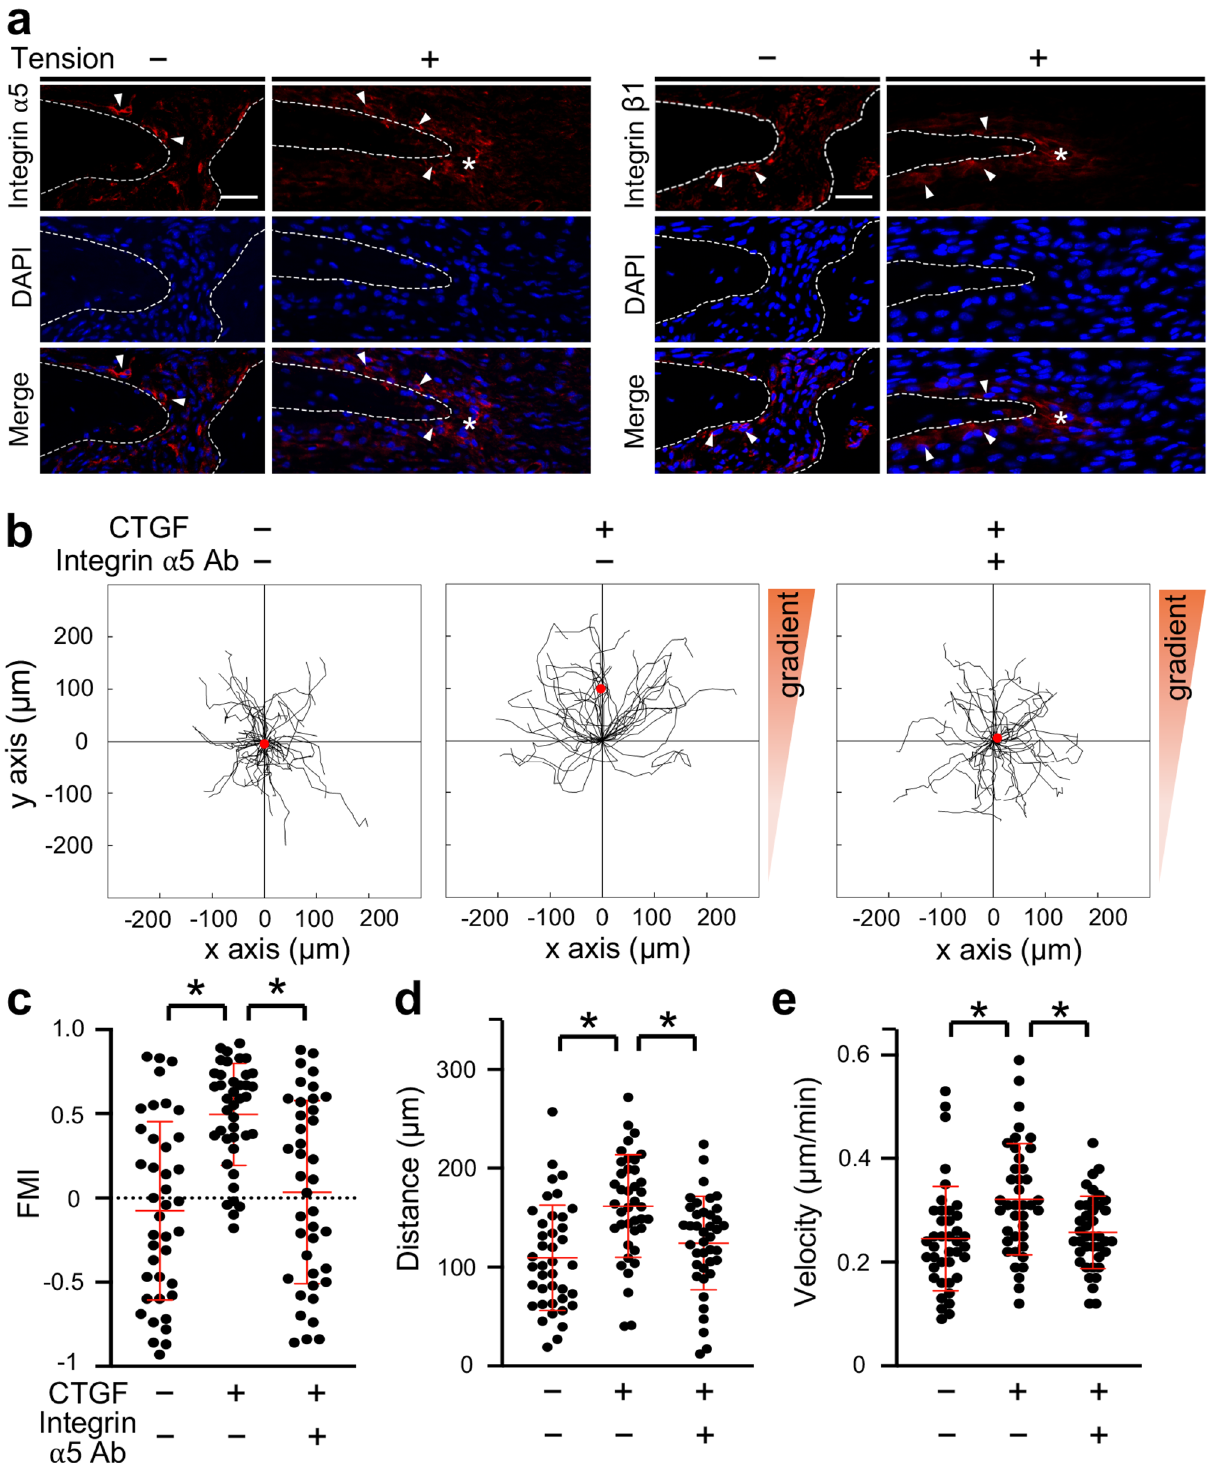
Figure 5. Neutralizing integrin α5 antibody suppressed the CTGF-induced chemotaxis of MC3T3-E1 cells. ( a ) The expression of integrin α5 and integrin β1 at the osteogenic front at 7 days after application of tensile force was analyzed by immunohistochemistry. Arrowheads indicate integrin α5- or integrin β1-positive osteoblasts. Asterisks indicate expression of integrin α5 or integrin β1 at the osteogenic front. The dotted line in the image of immunohistochemistry indicates the border of mineralized bone. Scale bar = 30 μm. ( b ) MC3T3-E1 cells were seeded onto an observation area between two reservoirs in a μ-slide chemotaxis chamber and cultured overnight. The cells in the observation area were pretreated with 5 μg/ml neutralizing integrin α5 antibody for 1 h. Then 150 ng/ml CTGF with or without 15 μg/ml neutralizing integrin α5 antibody was added to one reservoir and the cells allowed to migrate toward CTGF for 12 h. The migration paths of 40 individual cells were analyzed. The red dot represents the center of mass of the endpoints of tracked cells. The parameters FMI ( c ), distance ( d ), and velocity ( e ) were determined (n = 40). Integrin α5 Ab = neutralizing integrin α5 antibody. *p < 0.05, ANOVA with Dunn’s post hoc